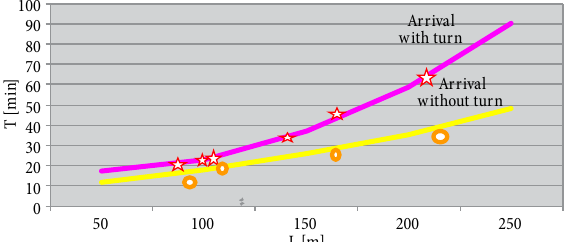
Fig. 9. Ship arrival time to Malkų Bay, including and excluding a turn, depending on the ship’s length received using the calculation method and experimental data on real ships